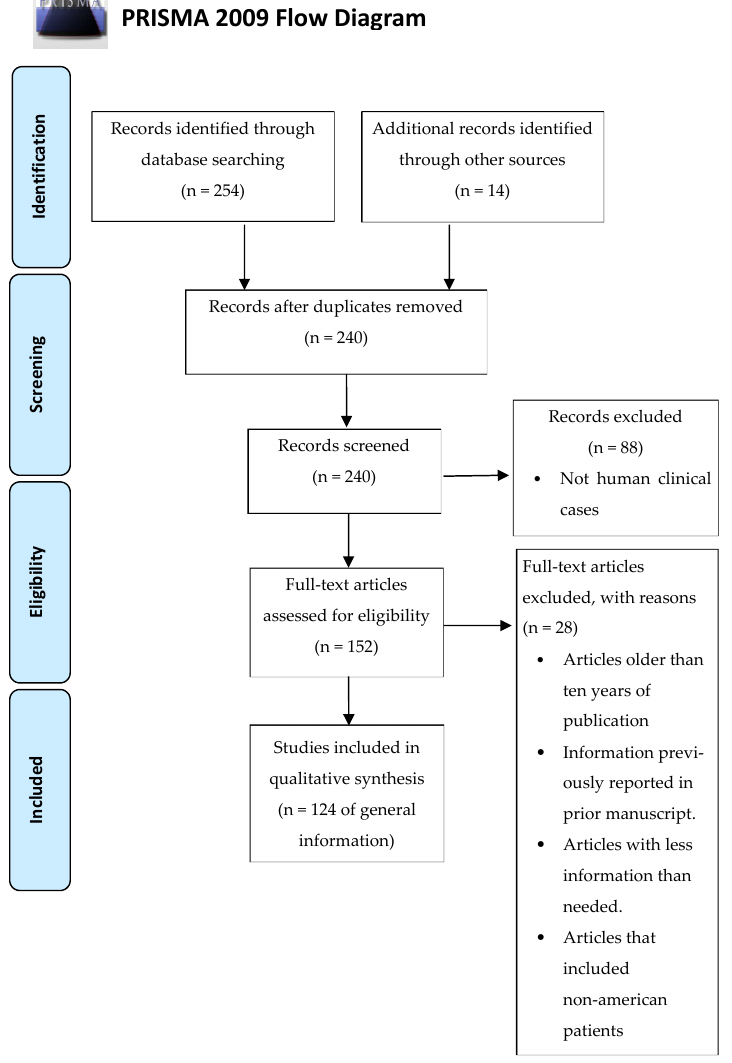
Figure 2. Flowchart of the different phases of the systematic review.